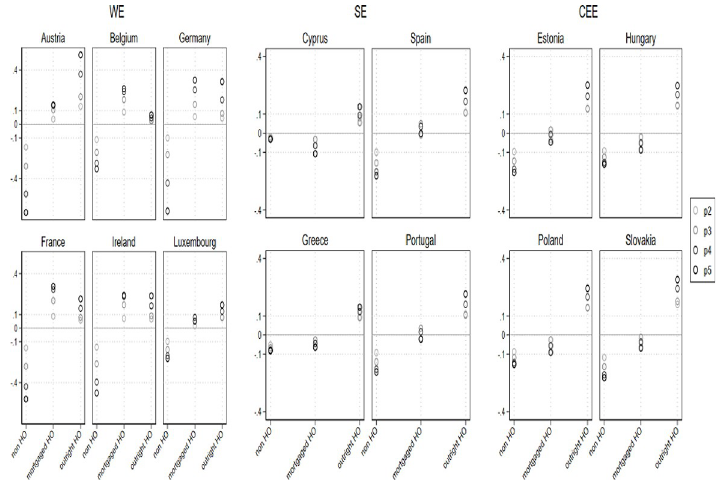
Fig 4. AME for pooled multinomial logistic regression predicting the difference in probability of housing tenure, by IWT quintiles and control variables.